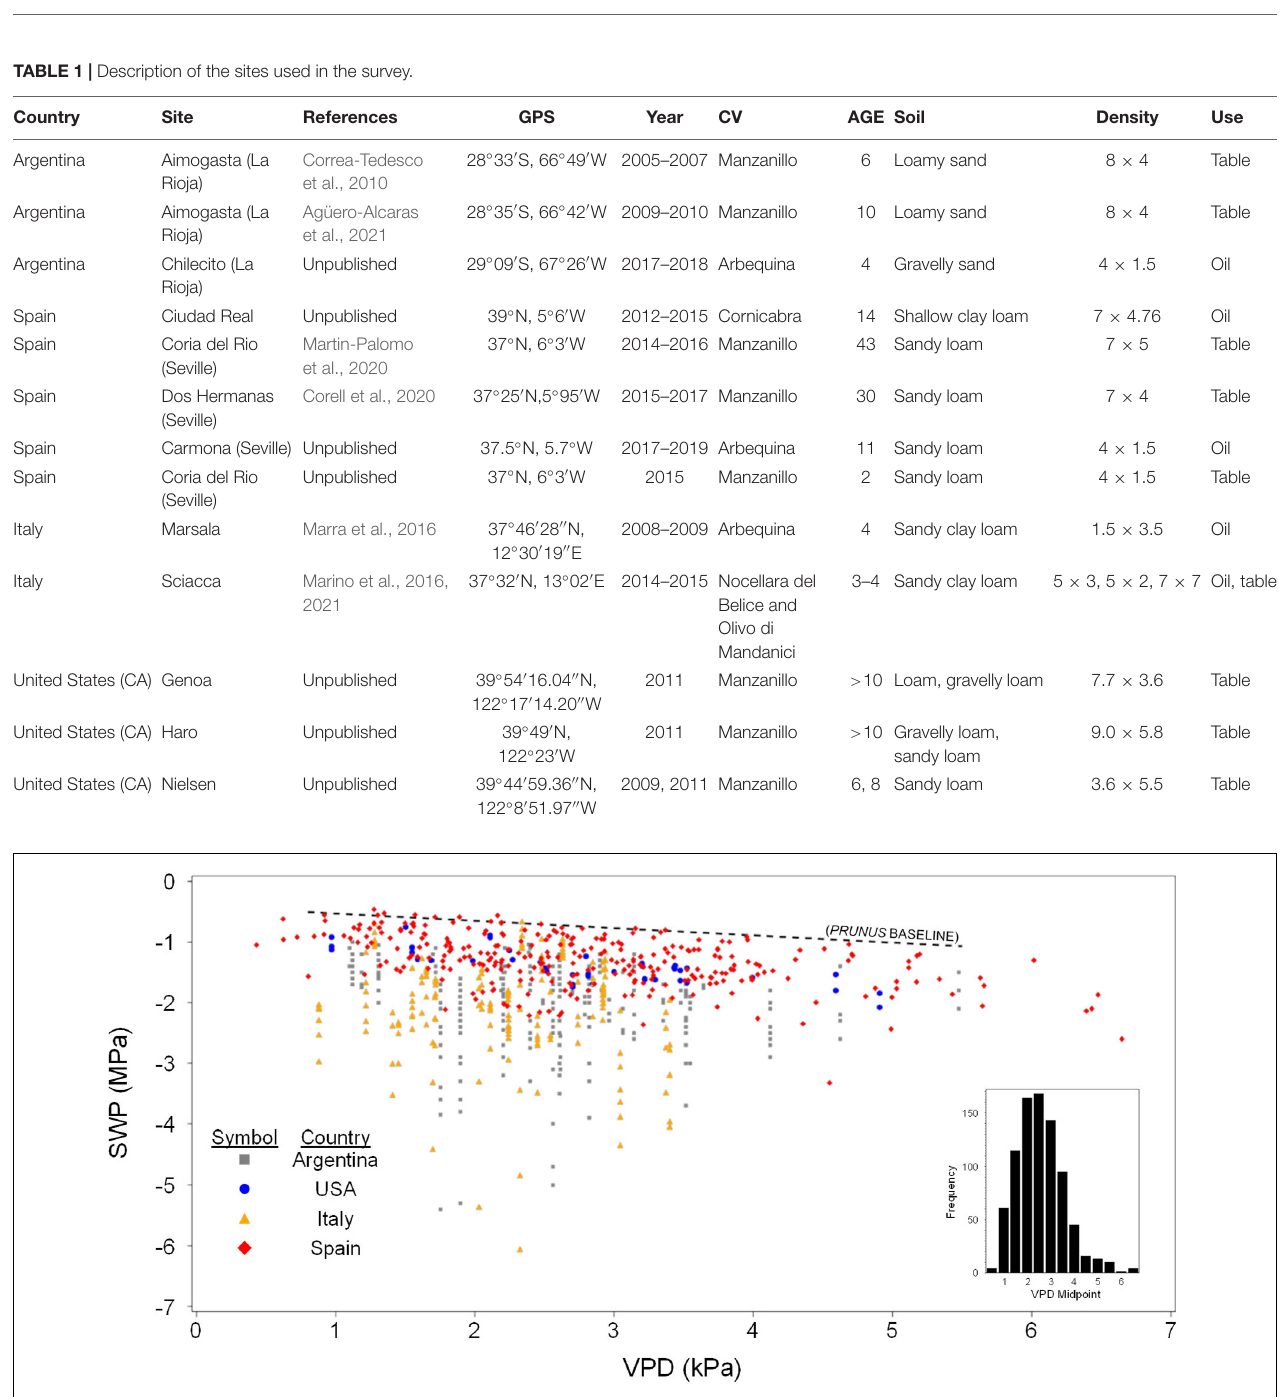
FIGURE 1 | All survey data of SWP to midday VPD from four countries. Each point is an individual measurement, with vertical lines of points indicating SWP values that were collected at the same site and time. Also shown for reference is the baseline relation found for Prunus (dashed line). Equation for the Prunus baseline is SWP (MPa) = –0.12 × VPD – 0.41. Inset shows the number of SWP measurements associated with each 0.5 kPa class of VPD.